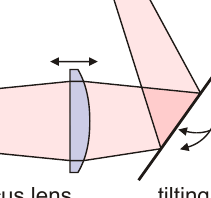
Figure 3. The PTB high-resolution bistatic lidar is mounted on a custom-designed trailer with a hinged cover (opened here), under which the optical set-up and the signal processing unit (SPU) are located.